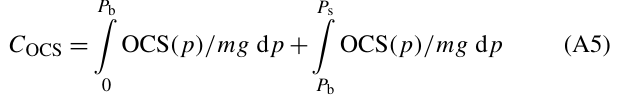
Figure A2. MkIV N 2 O profiles, color-coded by latitude (blue: 35 ◦ N; red: 67 ◦ N). The top panel looks similar to the OCS profiles in Fig. 2b. The bottom panel shows the same N 2 O data, but plotted versus pressure, and illustrates the linear relationship between N 2 O and pressure at the highest altitudes. The horizontal banding is an artifact of the 1km vertical grid used in the retrieval. The solid blue line represents the linear N 2 O–pressure relationship assumed for the mid-latitude balloon flights. The orange line shows the N 2 O– P relationship assumed for the extra-vortex high-latitude balloon